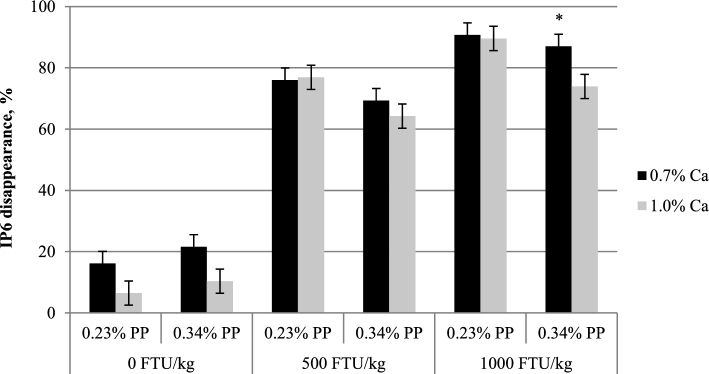
Effects of Ca on ileal IP6 disappearance (mean±SEM). Comparisons were made between birds fed the diets containing the same PP and phytase. * signifies a Ca effect (P < 0.05).